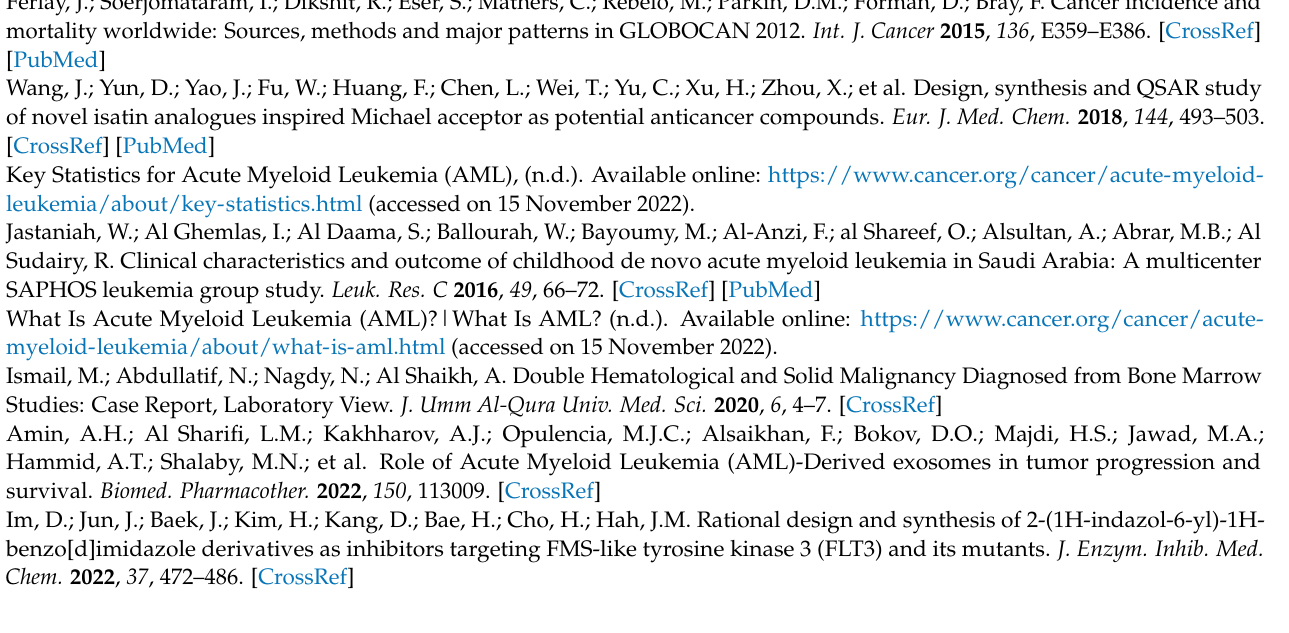
concentration after 48 h; Figure S23: One-dose mean graph of compound 5c against different cancer cell lines based on SRB assay at NCI at 10 µ M concentration after 48 h; Figure S24: One-dose mean graph of compound 5d against different cancer cell lines based on Sulforhodamine B (SRB) assay at NCI at 10 µ M concentration after 48 h; Figure S25: One-dose mean graph of compound 5e against different cancer cell lines based on SRB assay at NCI at 10 µ M concentration after 48 h; Figure S26: One-dose mean graph of compound 5f against different cancer cell lines based on SRB assay at NCI at 10 µ M concentration after 48 h; Figure S27: One-dose mean graph of compound 5g against different cancer cell lines based on Sulforhodamine B (SRB) assay at NCI at 10 µ M concentration after 48 h; Figure S28: One-dose mean graph of compound 5h against different cancer cell lines based on SRB assay at NCI at 10 µ M concentration after 48